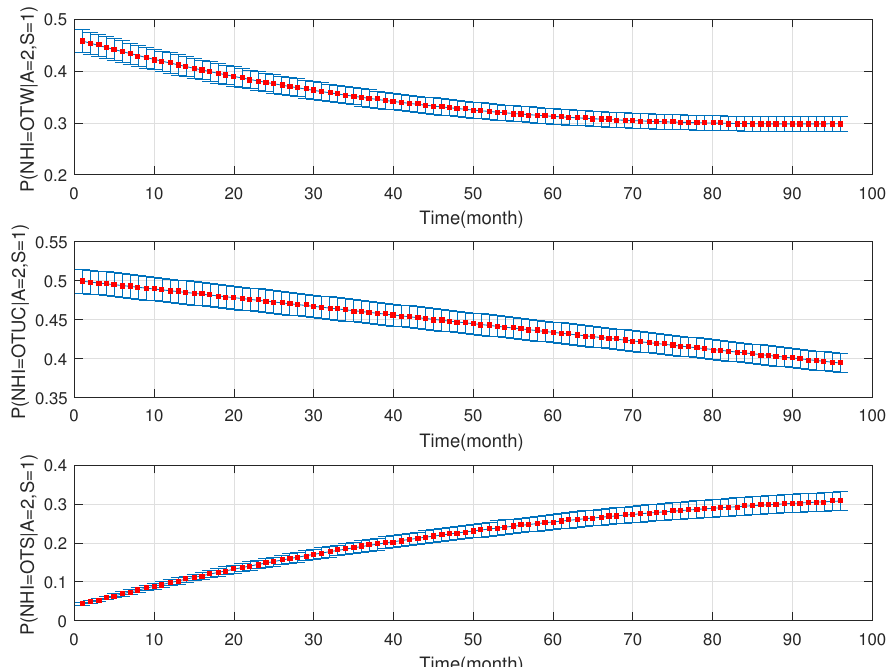
Figure 10. The probability of new herd incidents (officially TB free status withdrawn (OTW), officially TB free sta- tus unclassified (OTUC), officially TB free status suspended (OTS)) in high-risk areas of England for A: young cattle ( ≤ 24 months old); and S: silage fed.